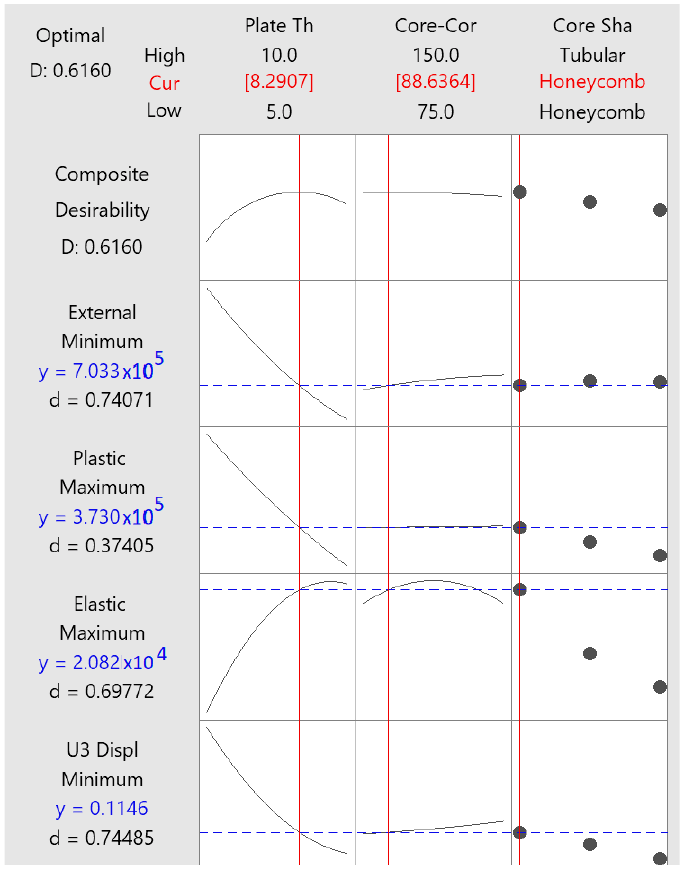
Figure 28. Multi-criteria optimal process parameters.